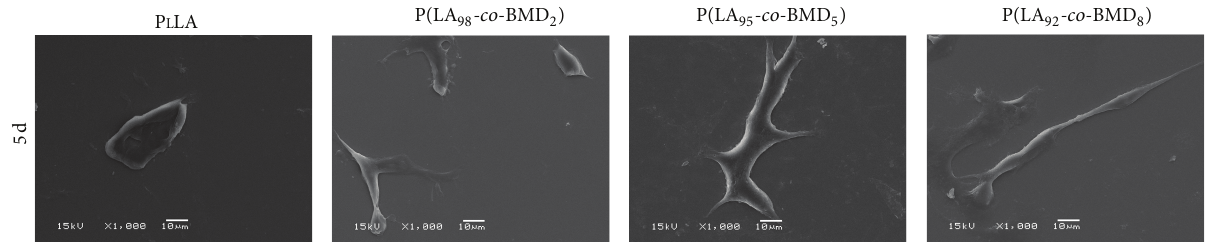
Figure 5: Scanning electron micrographs of PC12 cells seeded on the copolymeric films 5 days after isoleucine-lysine-valine-alanine-valine